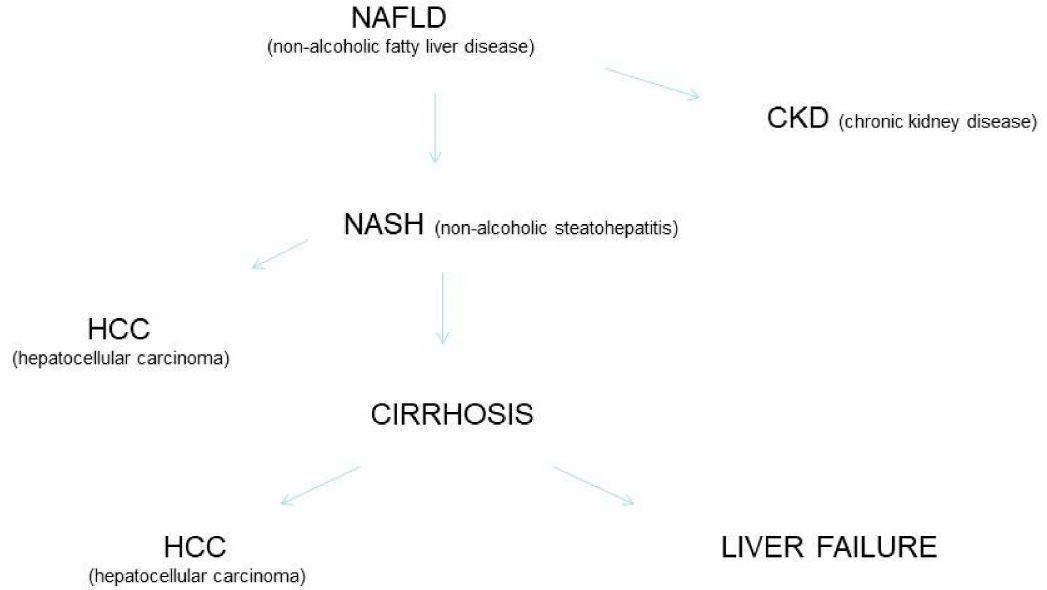
Figure 1. NAFLD, progression of liver damage and extra-hepatic